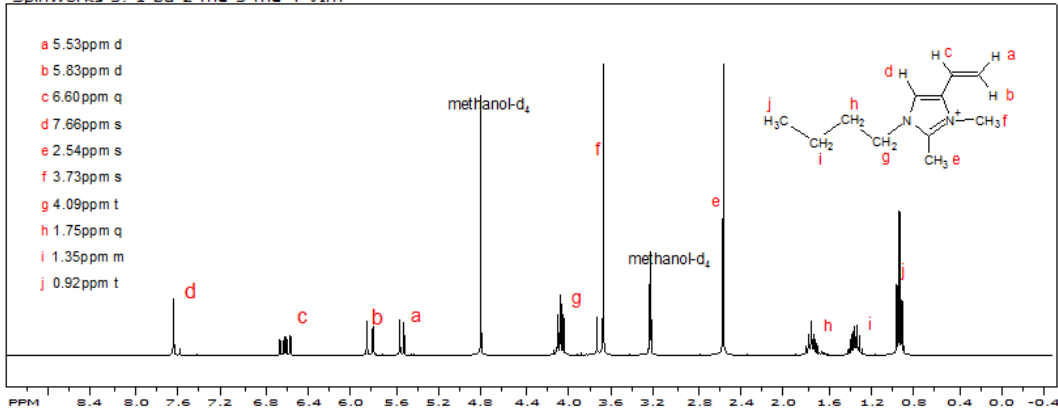
Each of the reactions in the sequence is inherently high yield; however, the yields of